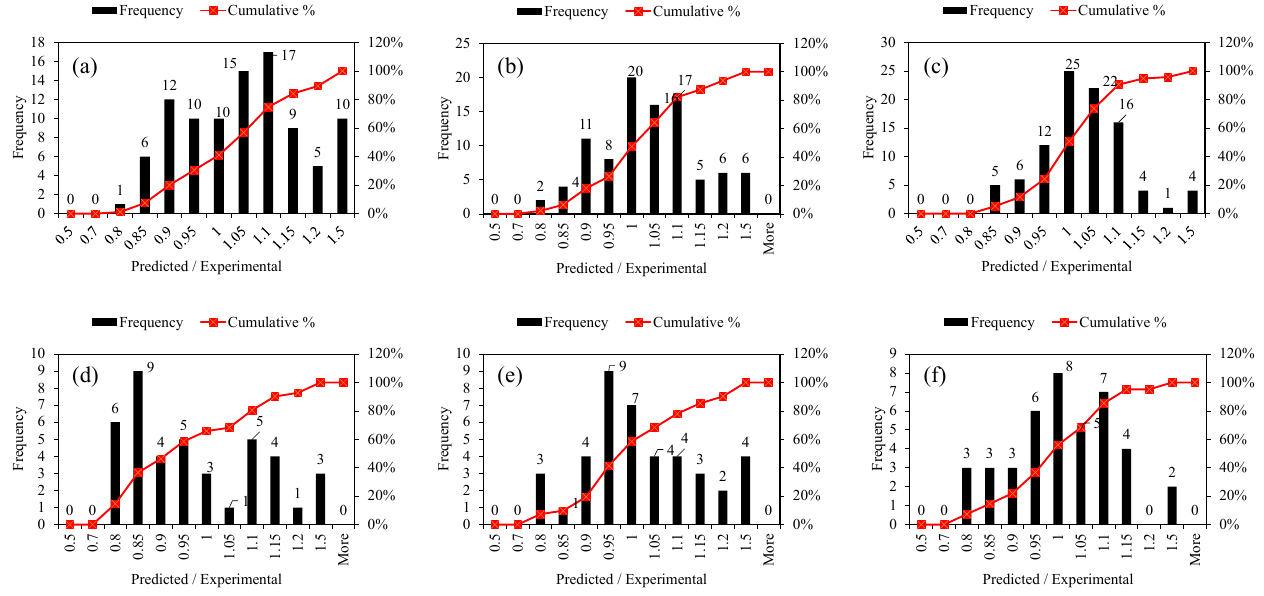
Figure 5. Frequency histograms of predicted-to-experimental ratios for the: ( a , d ) RF regression, ( b , e ) XGBoost, and ( c , f ) LIGHT GBM models for training and validation, respectively. Table 6. Frequencies of predicted-to-experimental ratios for the developed models.